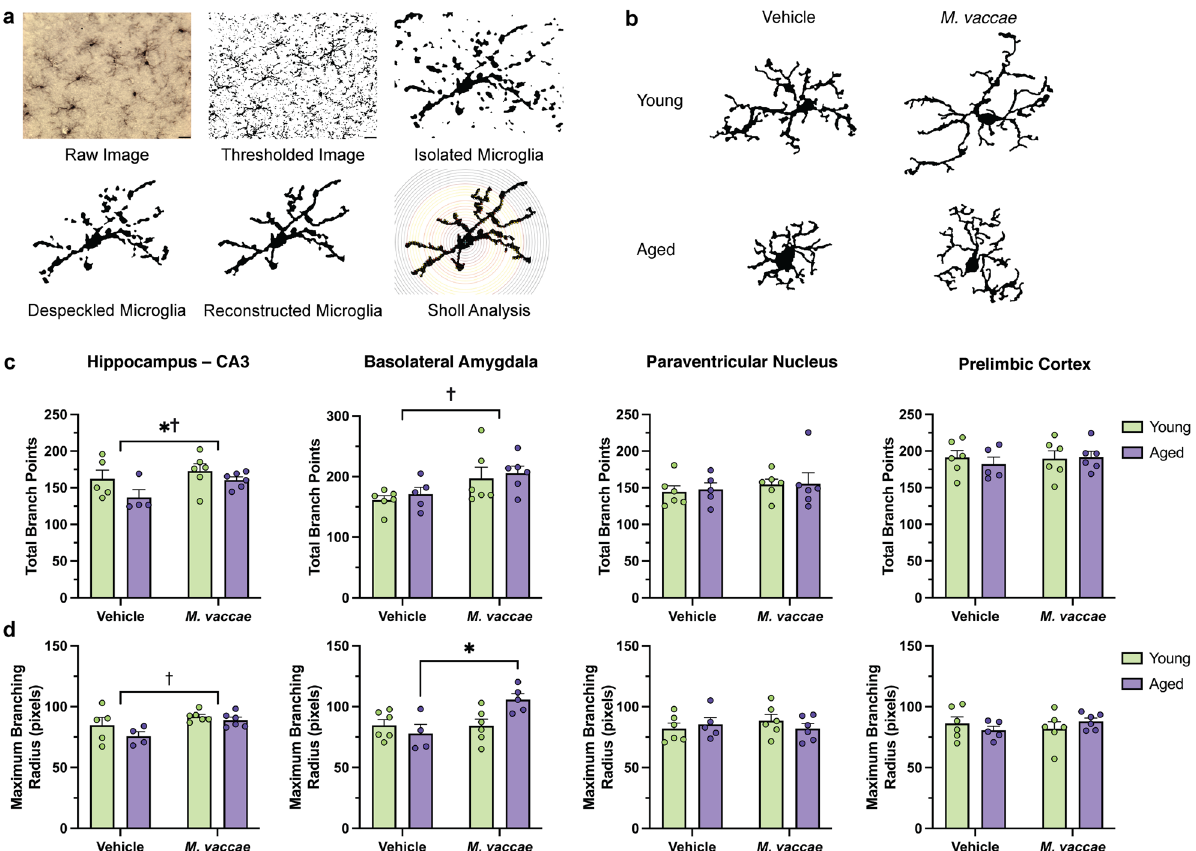
Figure 3. M. vaccae immunization induces microglial branching in the basolateral amygdala and CA3 hippocampal subfield of aged rats. ( a ) Methodology for performing a Sholl analysis. Microglia were thresholded, despeckled to remove background noise, and manually reconstructed while referring to the original image for accuracy. The Sholl analysis is then performed with concentric circles appearing at a starting radius of five pixels from the soma, and the step size was set at seven pixels. ( b ) Representative images of the Sholl analysis (to scale) demonstrating differences in microglial complexity across each group. ( c ) Total branch points were determined as the sum of all intersections between microglial processes and concentric circles. ( d ) Maximum branching radius was the distance where the highest count of intersections occurred. This reflects sites with the greatest branch density. The data are graphed as mean ± SEM; n = 4–6 rats/group (3–5 microglia/rat); scale bar = 20 μm; * p < 0.05 (Tukey’s post hoc test) or p < 0.05, main effect of age; † p < 0.05, main effect of M. vaccae